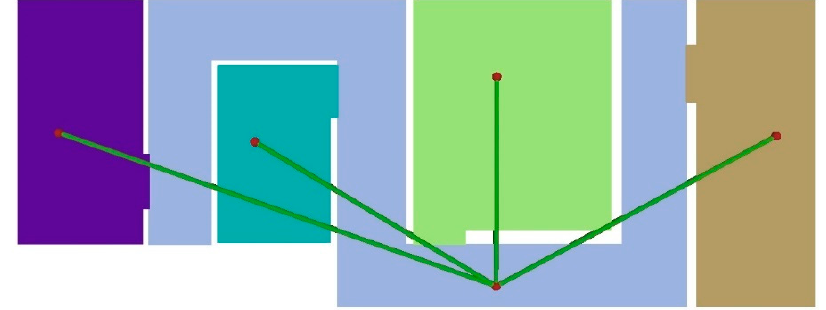
Figure 3. Basic indoor navigation network (NRS) with red nodes and green connections.